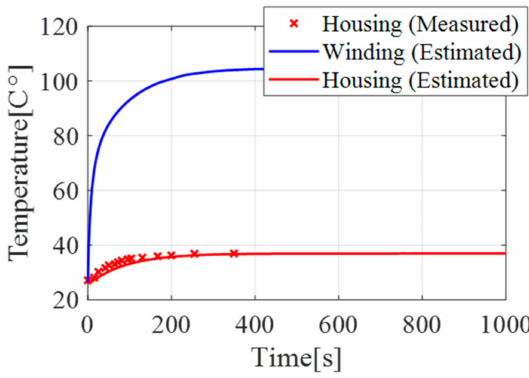
Figure 9. Thermal response of the 4-CoSMo actuator in the forced air-cooling